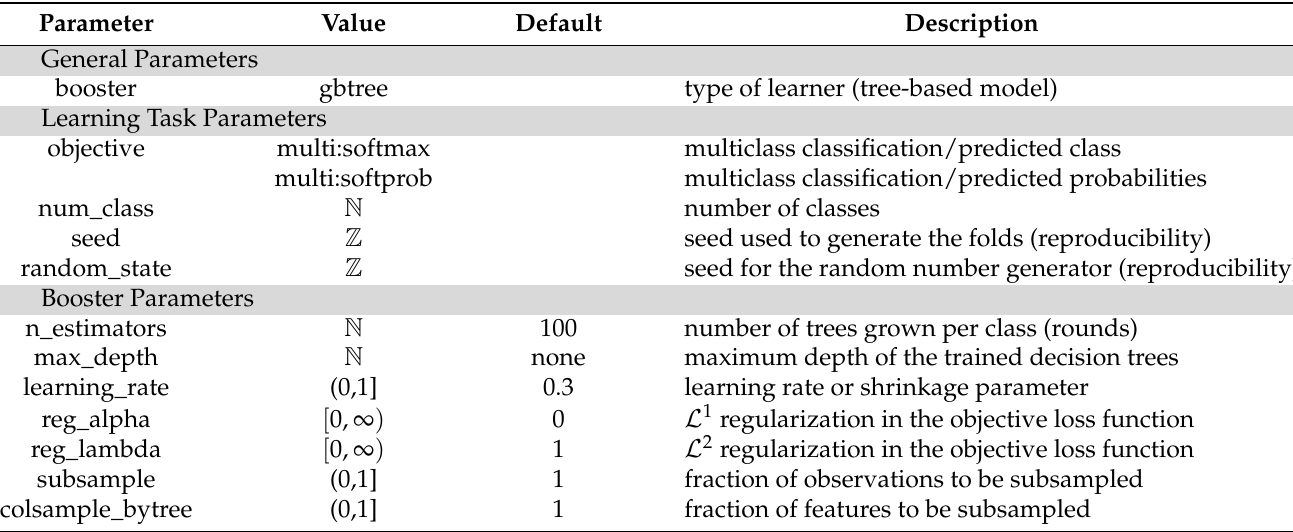
Table 4. Description of the key parameters used for XGBoost